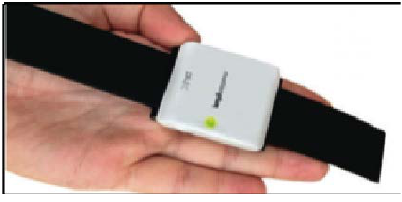
Figure 7. BIOPLUX motion bracelet.